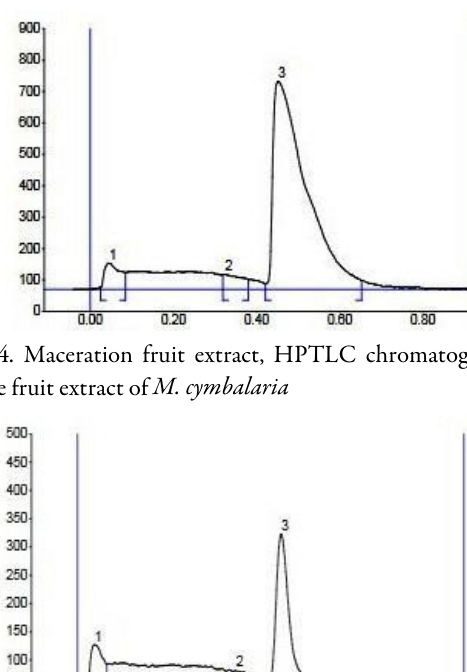
Fig. 11. HPTLC fingerprinting profile for various secondary metabolites present in M. cymbalaria fruit extracts and standards under 254 nm; lane-1-hexane, 2- ethyl acetate, 3- methanol (soxhalation), lane-4-hexane, lane-5-ethyl acetate, lane-6-methanol (reflux)